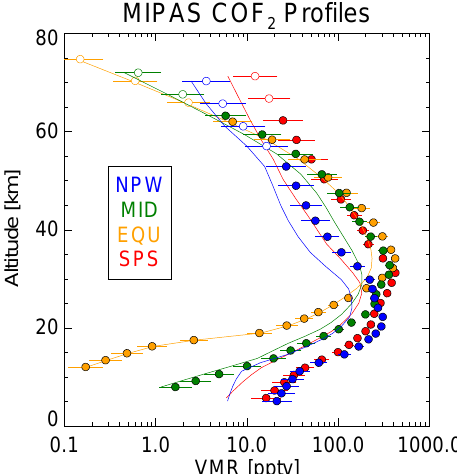
Figure 4. Examples of typical MIPAS retrievals of COF 2 profiles in cloud-free scenes for north polar winter (NPW), northern midlat- itude (MID), Equator (EQU), and south polar summer (SPS) condi- tions. Retrieved profiles are shown by circles, with error bars repre- senting the retrieval random error; open symbols are profile levels where this exceeds 70% of the VMR and so excluded from these analyses. The lines represent the a priori profiles for each retrieval (the a priori error is assumed to be 100%, i.e. a factor of two uncer- tainty). Profiles are all selected from 22 December 2011, details as follows: NPW Orbit 51319, (80.0 ◦ N, 98.8 ◦ W); MID Orbit 51312, (37.6 ◦ N, 10.4 ◦ E); EQU Orbit 51312, (0.3 ◦ S, 96.4 ◦ W); SPS Orbit 51312 (81.6 ◦ S, 44.9 ◦